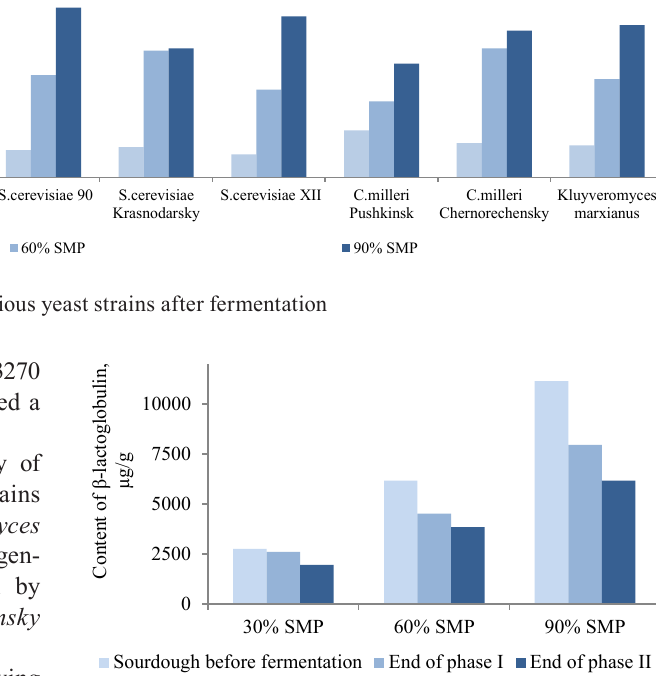
Figure 3 Content of β-lactoglobulin in the sourdough before and after fermentation at the end of phases I and II